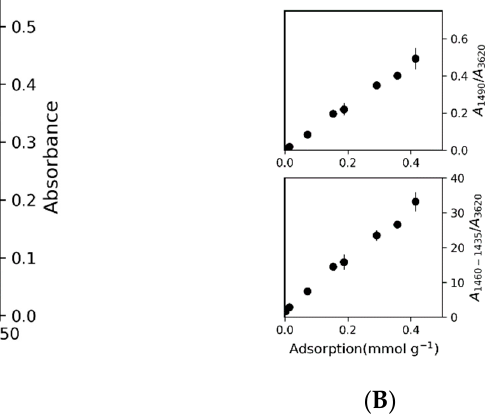
Figure 4. ( A ) ATR-FTIR spectra of CBZ (black, OD values on the right axis), bentonite raw clay (blue), and bentonite with added CBZ (in mmol g − 1 ) as denoted in the legend (OD values on the left axis). ( B ) Normalized absorption bands’ height at 1490 and area at 1460–1435 cm − 1 compared to the adsorption results as measured by the mass balance during the adsorption experiments.